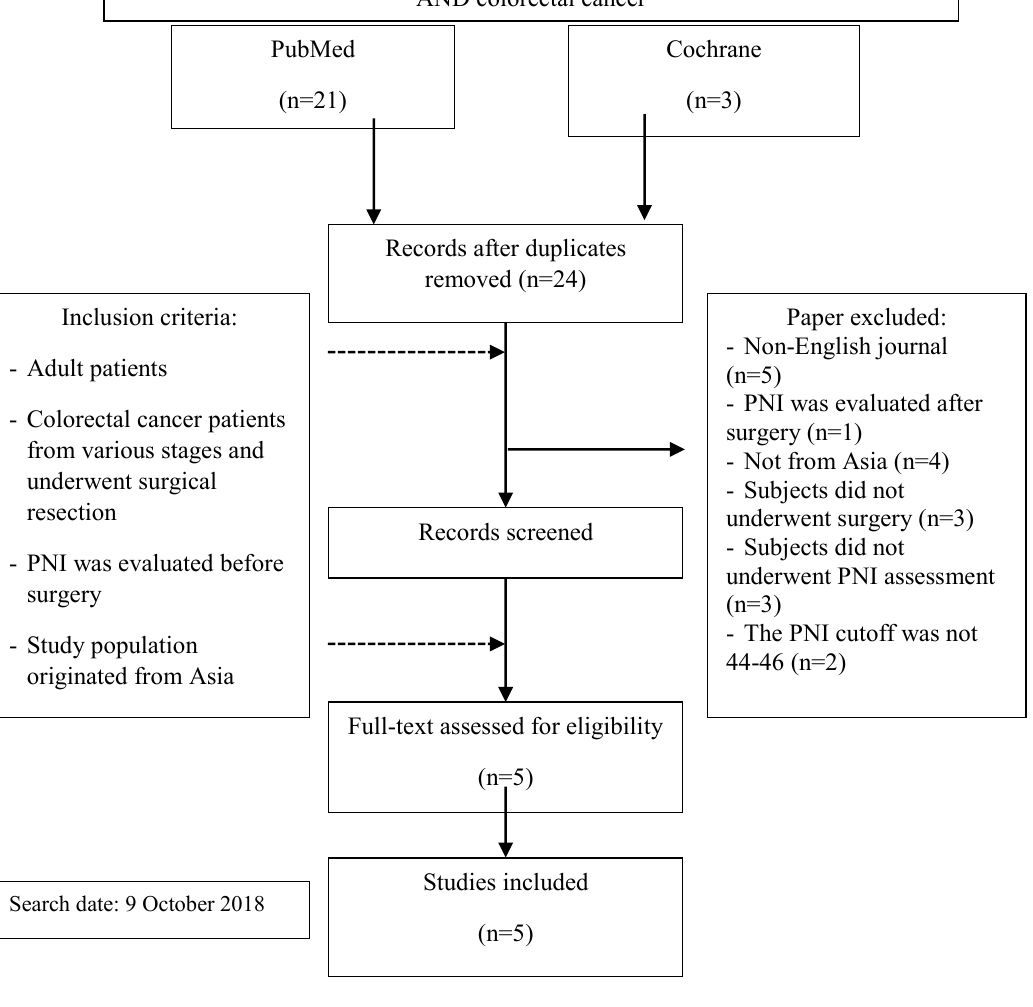
Figure 1. PRISMA